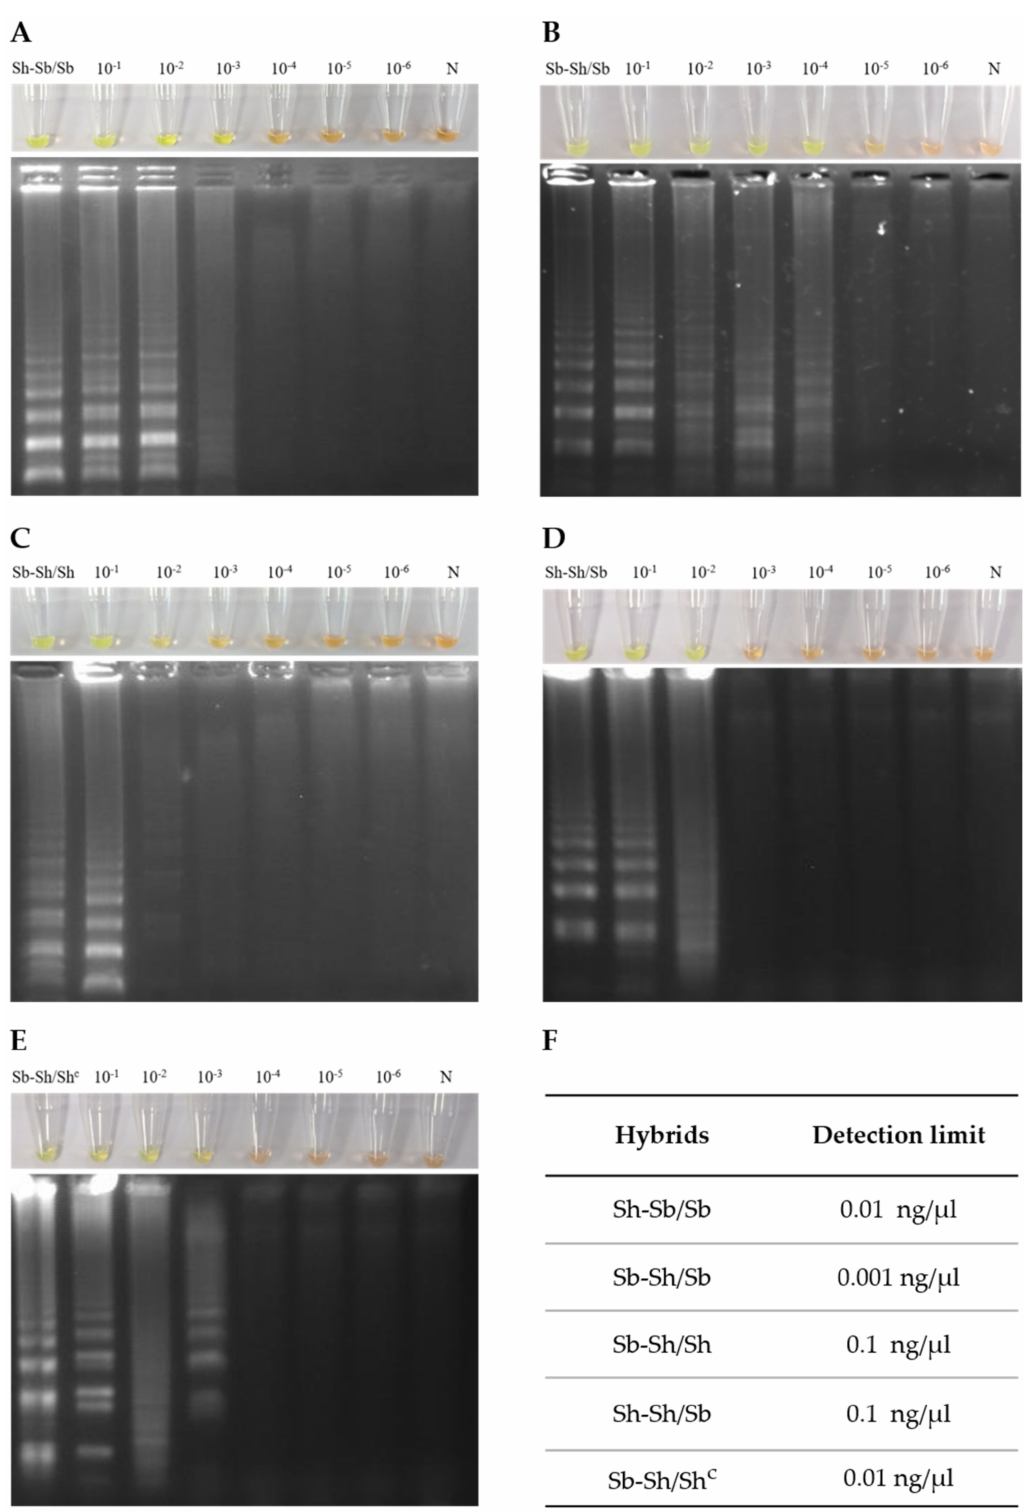
Figure 2. Assessment of genus-specific LAMP analytical sensitivity for hybrid schistosomes using gDNA serial dilutions. The figure shows the genus-specific LAMP results by color change (top) and in agarose electrophoresis (bottom) for each hybrid schistosome tested: ( A ) Sh-Sb/Sb; ( B ) Sb-Sh/Sb; ( C ) Sb-Sh/Sh; ( D ) Sh-Sh/Sb and ( E ) Sb-Sh/Sh c ). ( F ) Summary table indicating the genus-specific LAMP detection limit for detecting each hybrid. Lanes 10 − 1 –10 − 6 : 10-fold serial dilutions. N, negative control (no DNA